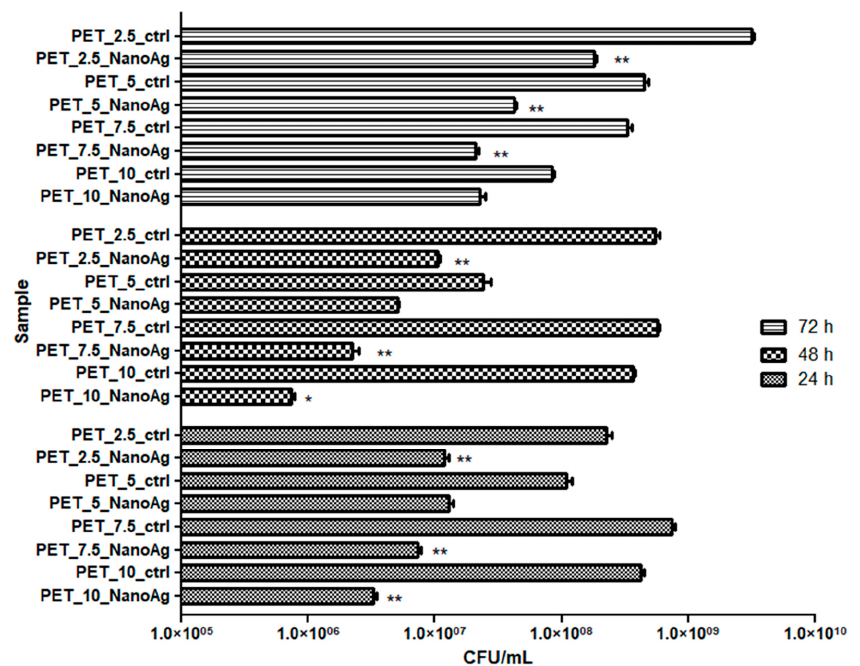
Figure 9. Graphic representation of CFU/mL, representing the number of P. aeruginosa viable cells included in the monospecific biofilms developed on the surface of the materials, quantified after 24 h, 48 h, and 72 h at 37 °C. * p ≤ 0.001, ** p ≤ 0.05 comparing control PET and NanoAg PET obtained at the same flow rate.